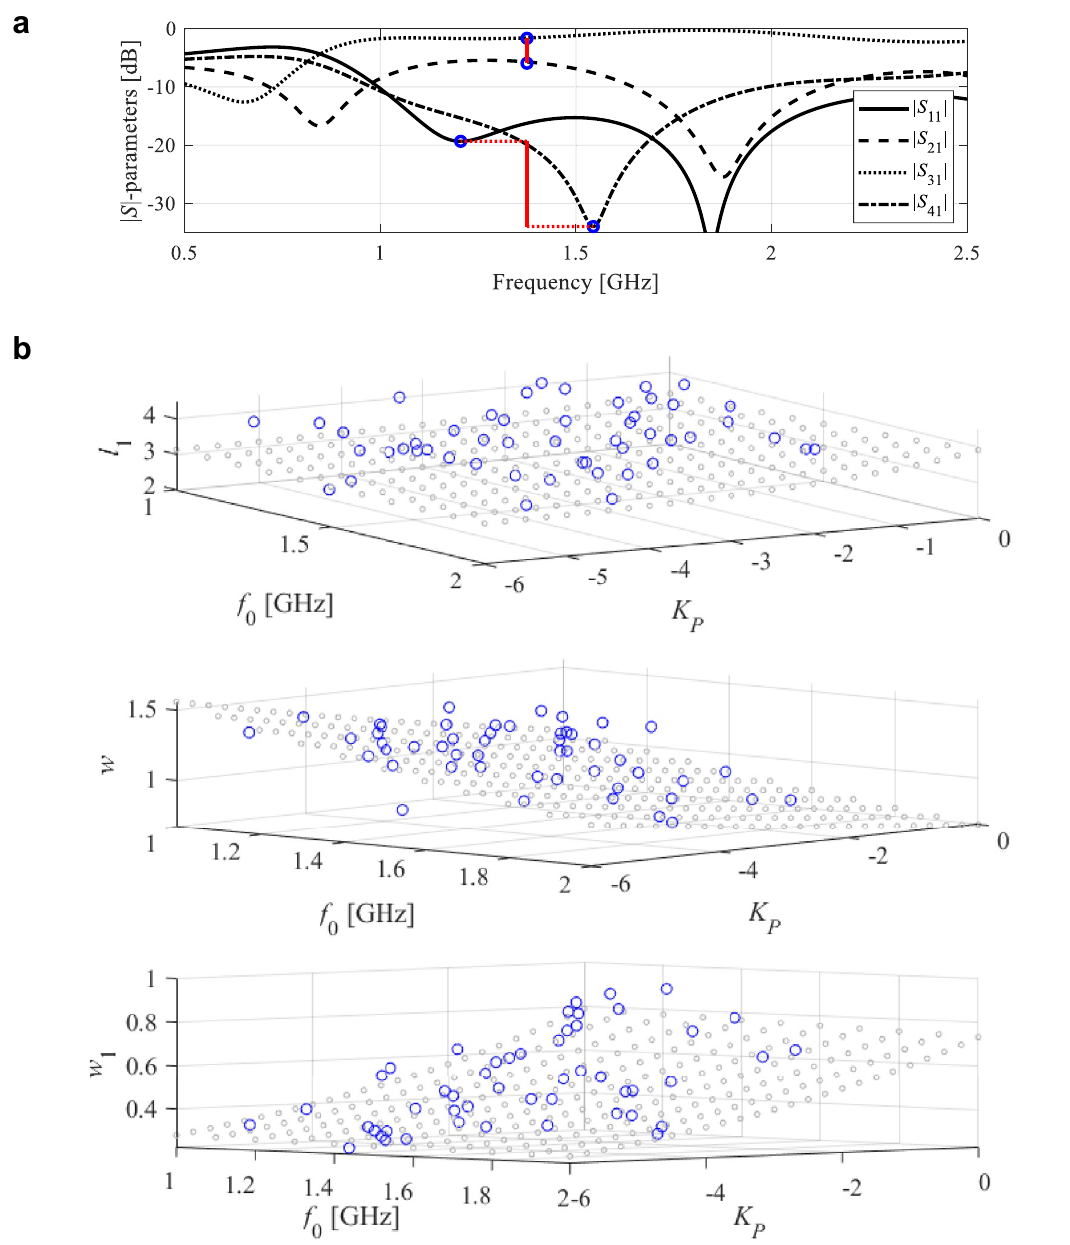
Figure 2. Miniaturized coupler of Fig. 1a: ( a ) response features: minima of | S 11 | and | S 41 | and power split ratio K P (o); K P is evaluated at the frequency (approximate operating frequency f 0 of the circuit) being the average of the said minima (thick vertical line); ( b ) relationship between f 0 and K P and the three selected geometry parameters; the circles mark coupler designs and the gray points denote the regression